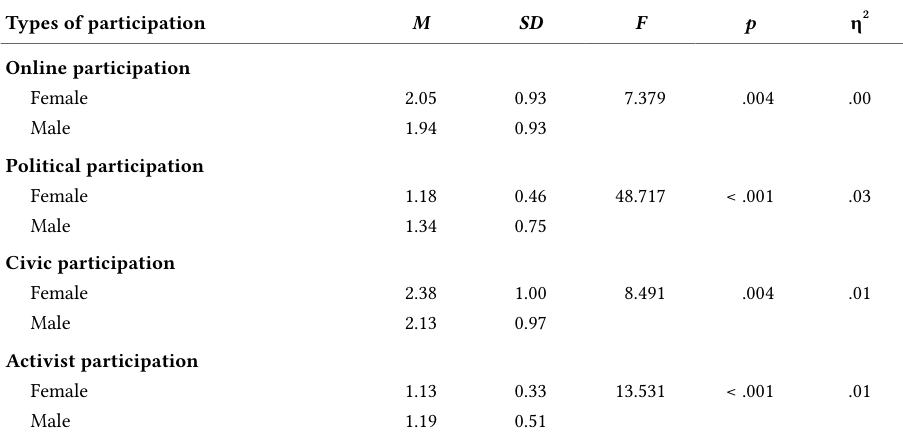
Differences Between Female and Male Participants Regarding